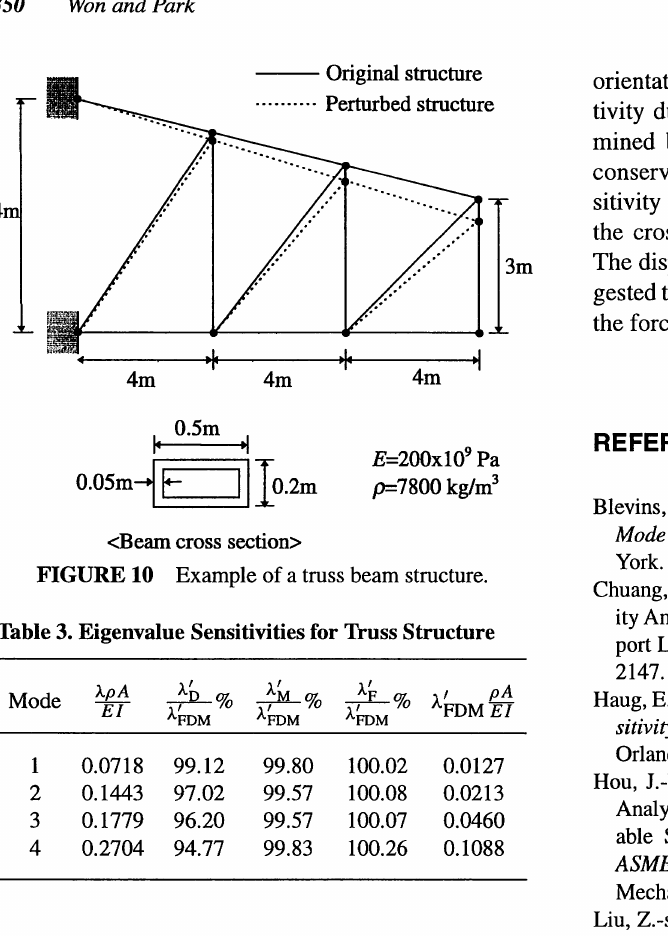
FIGURE 10 Example of a truss beam structure. Table 3. Eigenvalue Sensitivities for Truss